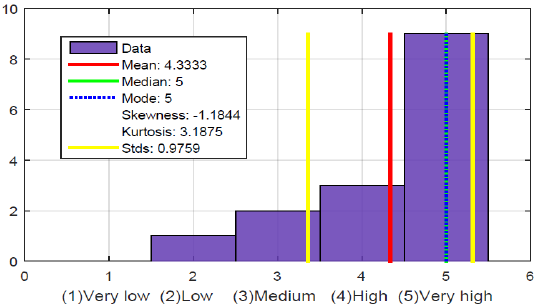
Figure 18. What level of perception do you have regarding the ball location on the soccer field while listening to the TV commentary?